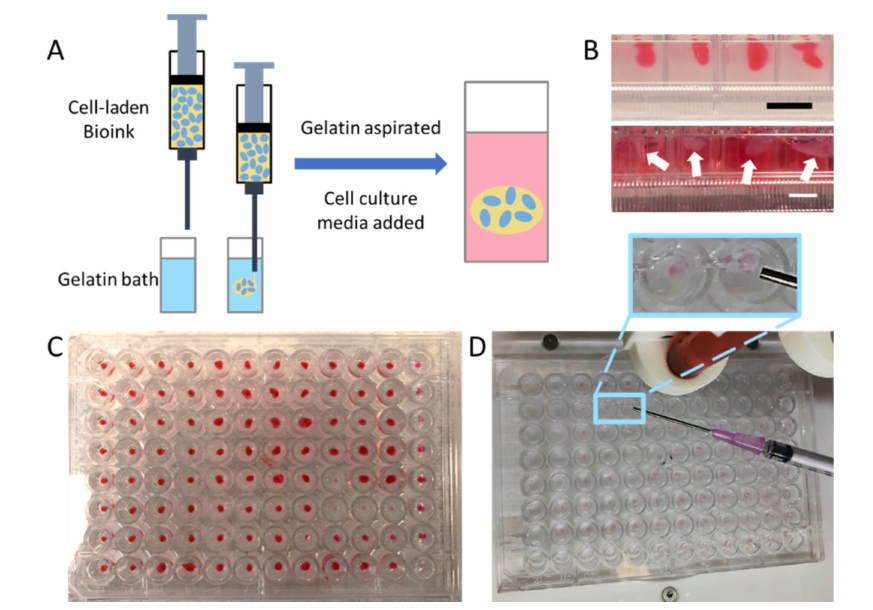
Figure 2. Schematic of the printing process using 2 bioinks in two commercially available bioprinters. The CellInk Inkredible and Allevi 2 printers were used. ( A ) Diagram of immersion printing into a support gelatin bath. Once printing is completed, the support gelatin bath is removed and the cells are left to culture in media. ( B ) Images of the organoids in the 96-well plate are shown at both steps of the process (scale bar = 5 mm). ( C ) Image of thiolated hyaluronic acid (HA) and methacrylated collagen immersed in gelatin with Irgacure (crosslinking agent). ( D ) Image of Hystem hydrogel. Inset image: With the HyStem hydrogel, we ran into problems with it crosslinking mid-print, thereby connecting wells with